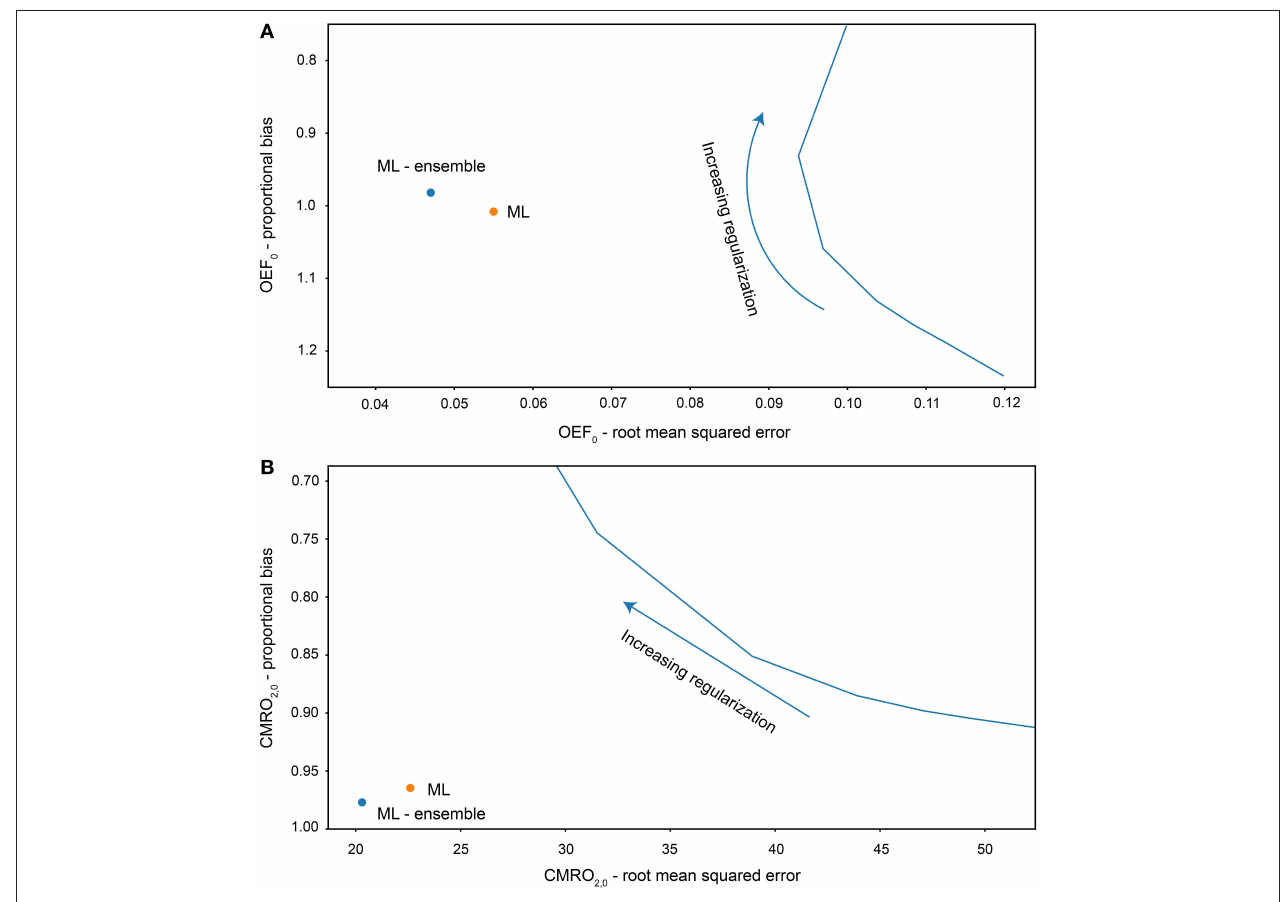
FIGURE 3 | Root mean squared error and proportional bias in OEF 0 (A) and CMRO 2,0 (B) estimates for each analysis method fitting to simulated data (5,000 simulations). Solid blue line plots the error and bias for increasing regularization weighting for the regularized non-linear least squares